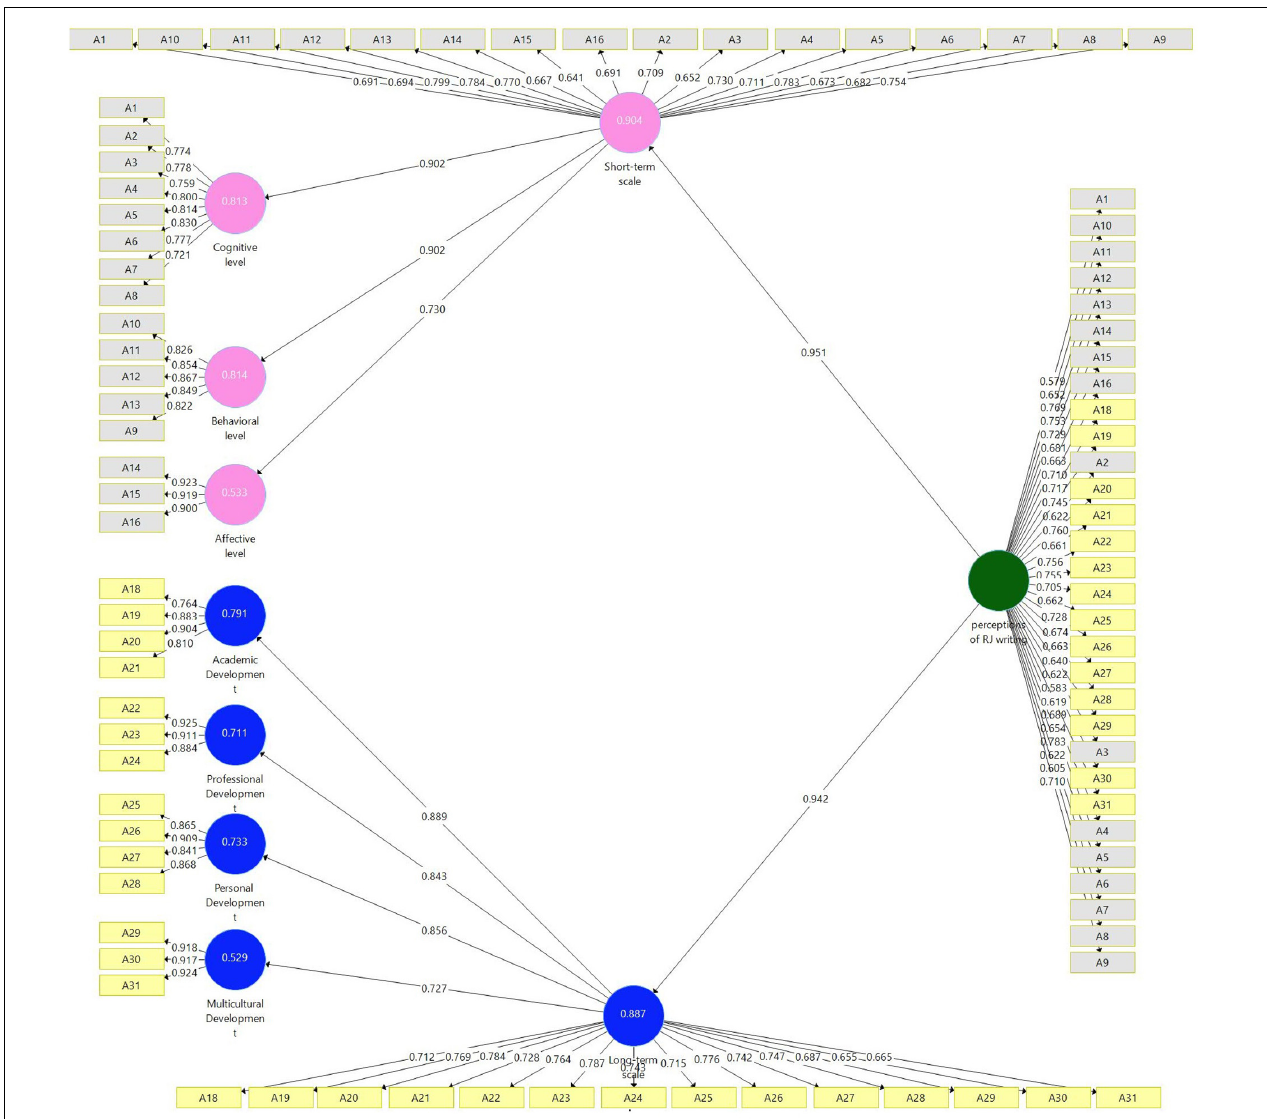
FIGURE 1 | Model 1. Analysis results of the examination of the reflective measurement model by